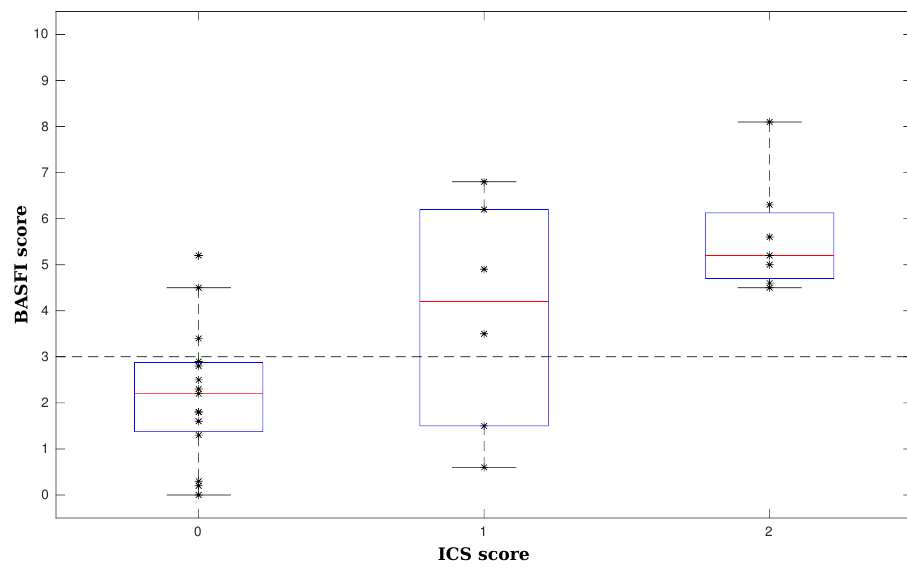
Figure 6. A comparison of objective ICS and subjective BASFI. Individual BASFI values are shown as asterisks (*), grouped according to their assigned ICS score value. The box plots capture their general